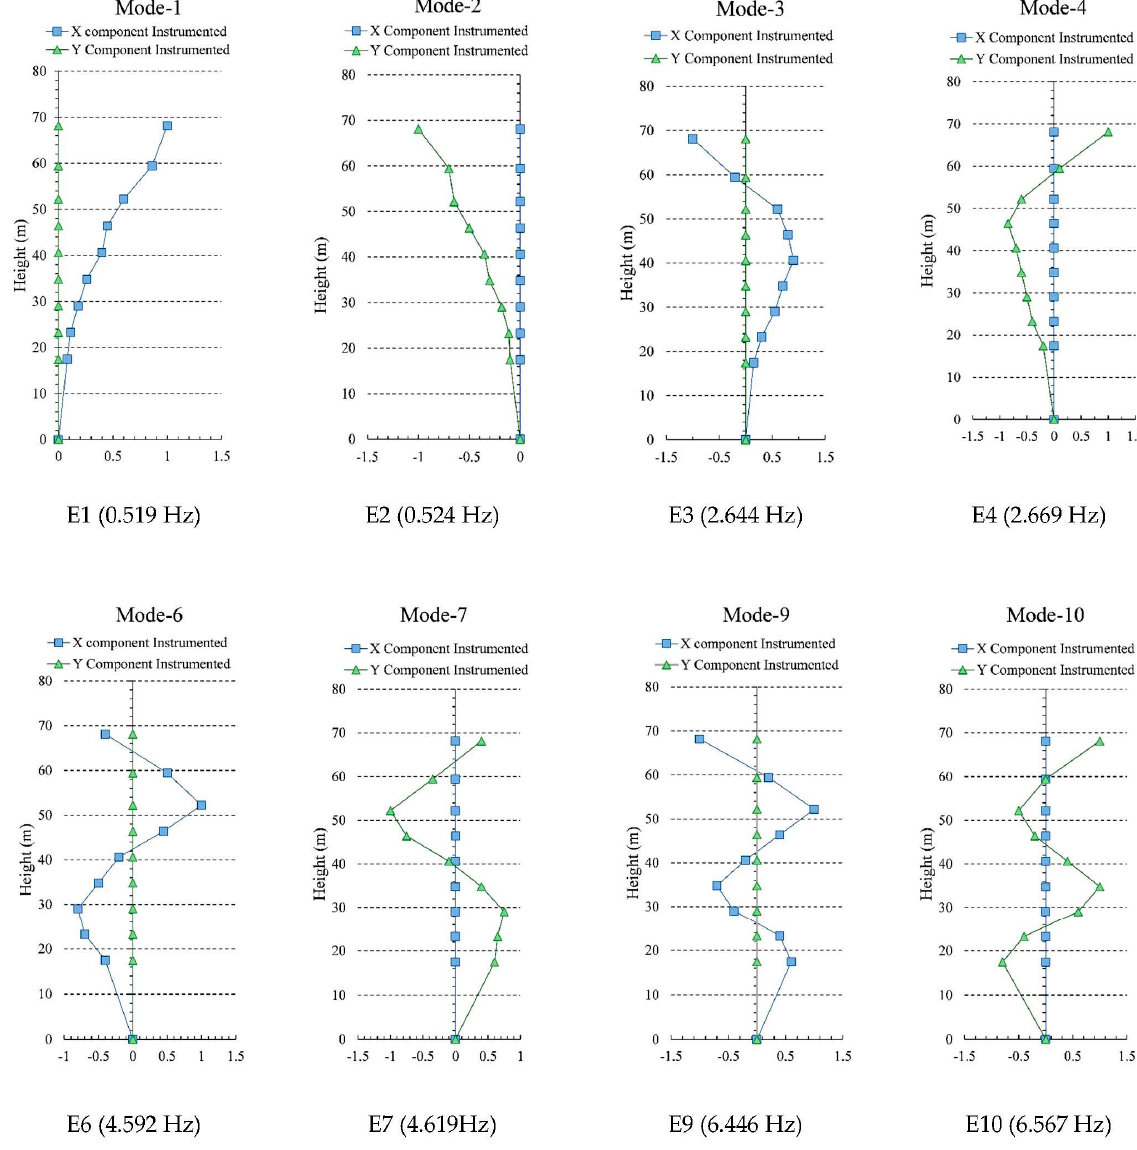
Figure 5. Experimental mode shapes in an elevation view.